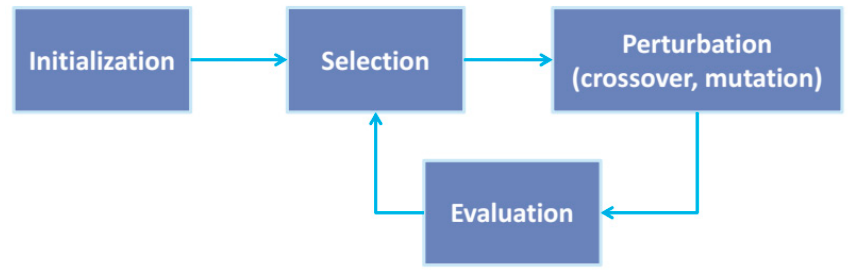
Figure 7. General scheme of a population-based algorithm [31].